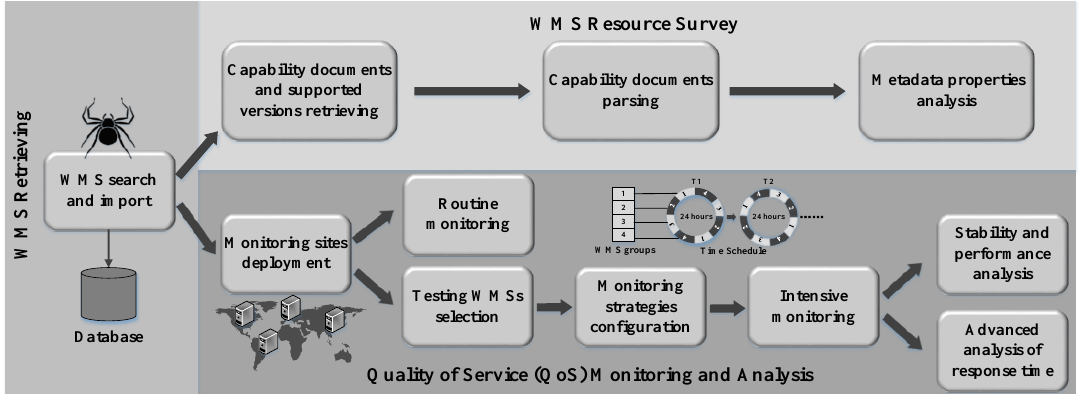
Figure 1. Data collection and analysis workflow.